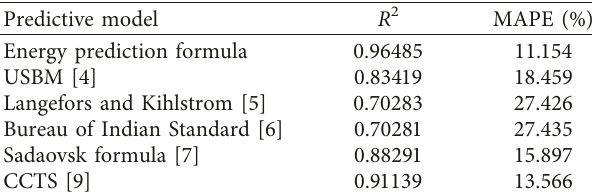
Figure 15: Measured PPVs against predicted PPVs fitted by CCTS. Table 9: Performance indices of all prediction models.